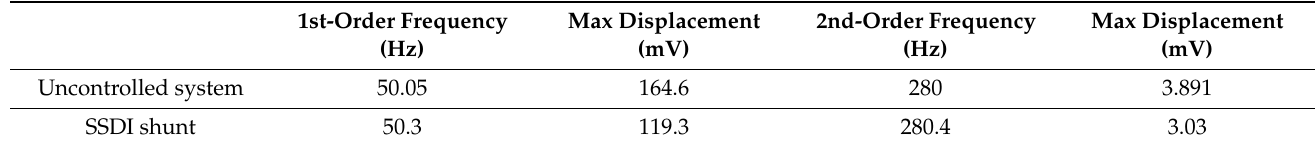
Figure 25. Frequency response curves with and without the SSDI (white noise). Table 4. Damping comparison results of the single beam with and without SSDI shunt.